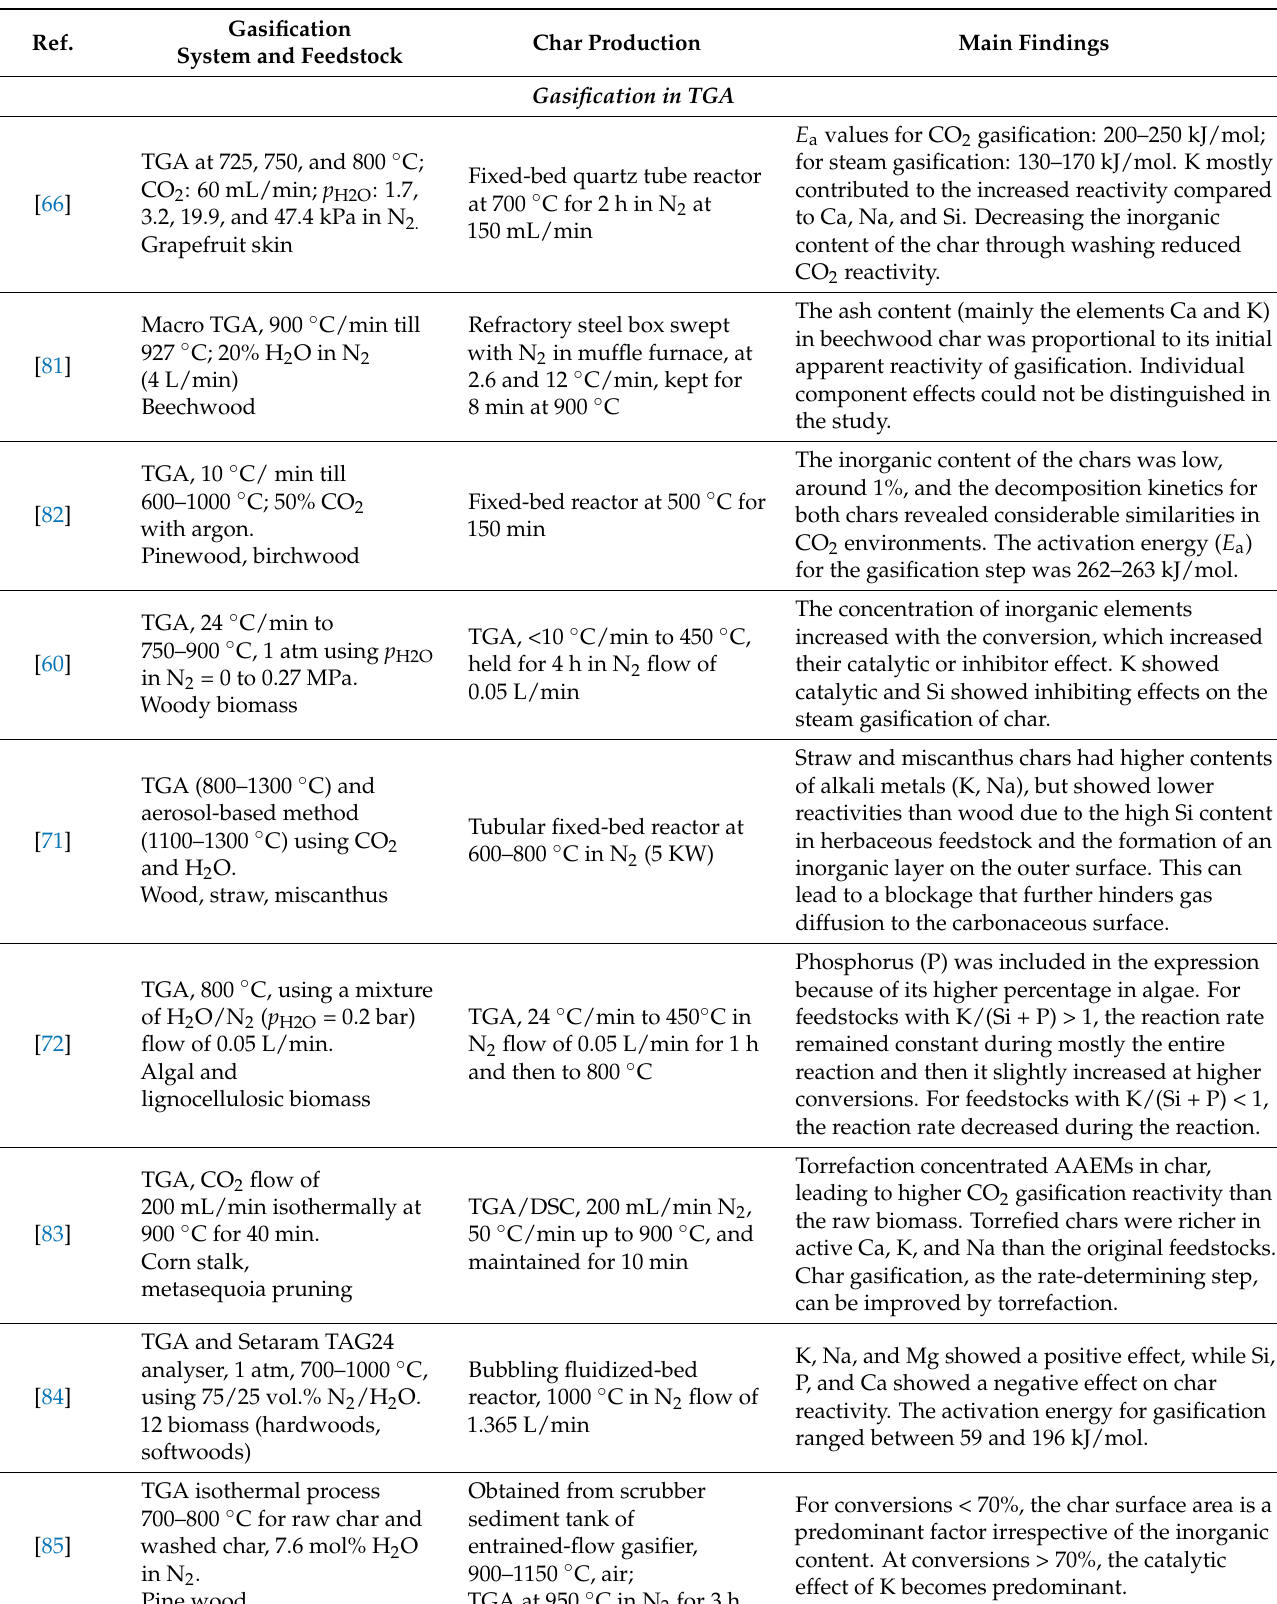
Table 3. Experimental studies investigating the effects of inherent inorganic content on the gasification of